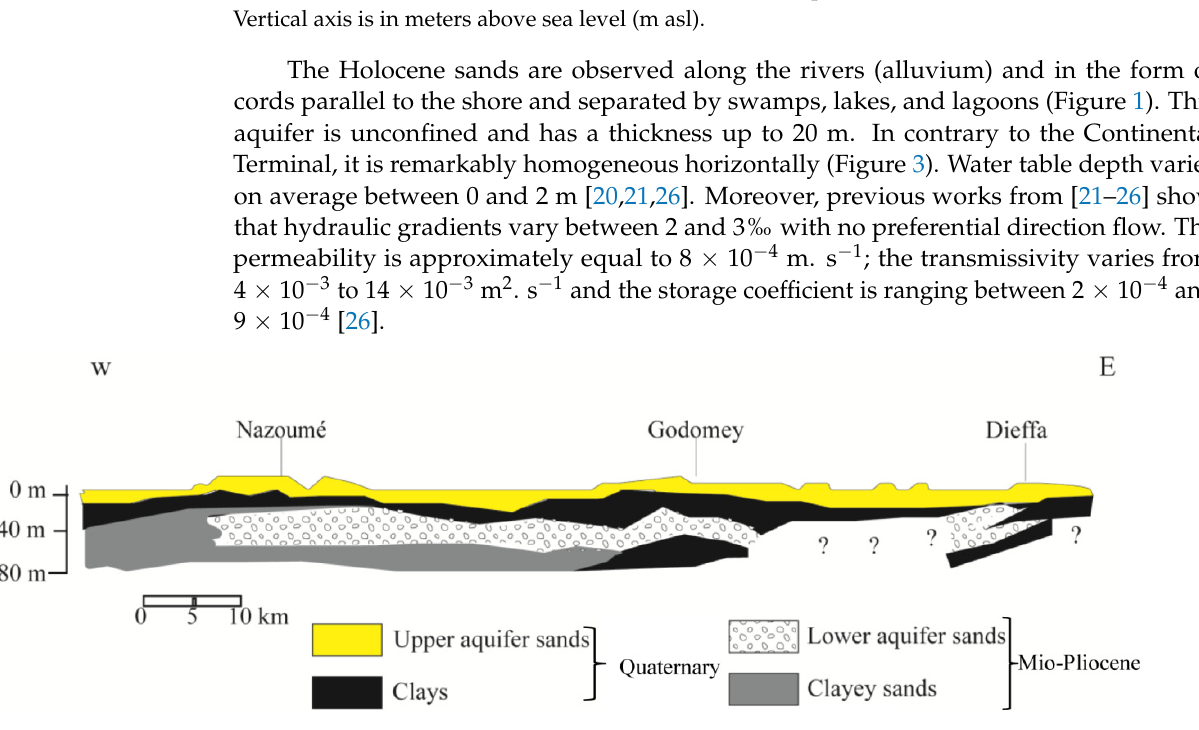
Figure 3. West–East geological cross section along the coastal plain of Benin [20,21,26]. Question marks indicate levels or depths with no available data or references. Vertical axis is in meters above sea level.